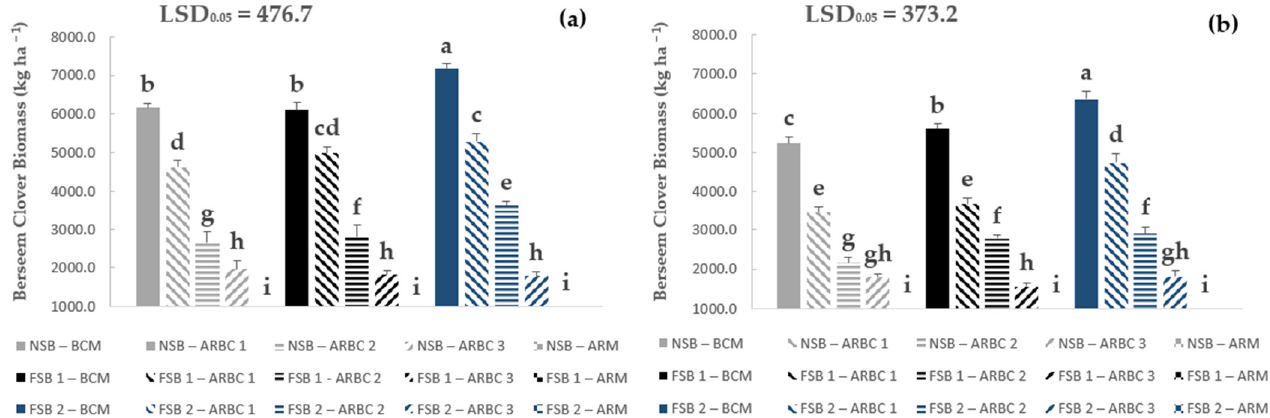
Figure 6. Biomass of berseem clover (kg ha − 1 ) in the first harvest. Data refer to the interaction between seedbed (S) and forage (F) factors in ( a ) 2020–2021 and ( b ) 2021–2022. NSB: Normal seedbed, FSB 1: First false seedbed, FSB 2: Second false seedbed, BCM: Berseem clover monoculture, ARBC 1: First intercrop with annual ryegrass and berseem clover in a 25:75 ratio, ARBC 2: Second intercrop with annual ryegrass and berseem clover in a 50:50 ratio, ARBC 3: Third intercrop with annual ryegrass and berseem clover in a 75:25 ratio, ARM: Annual ryegrass monoculture (see text in Section 2.2 for details). Numbers followed by the same letter are not significantly different. Vertical bars indicate standard errors.